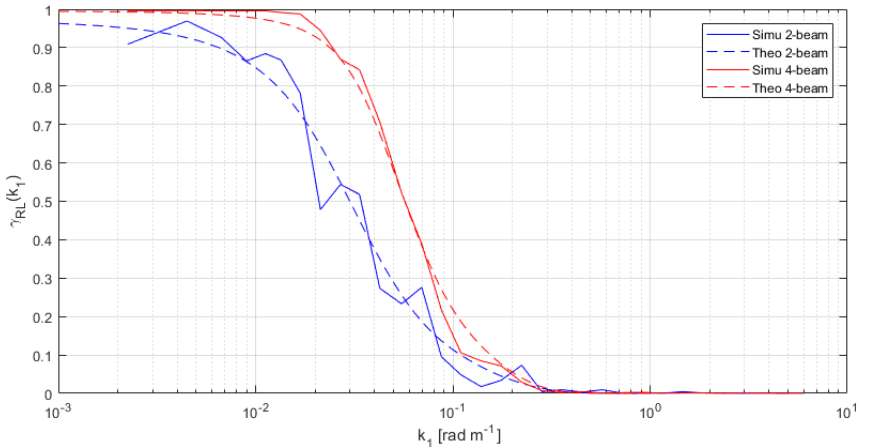
Figure 2. Coherence between the estimation of REWS from the turbine and the lidar. The comparison between the numerical simulations (Simu) and the implementation of the model (Theo) shows very good agreement.